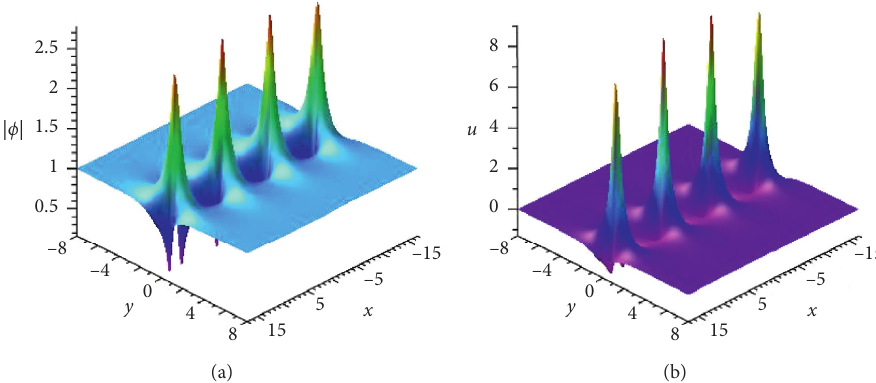
Figure 1: The one-breather solutions | ϕ | and u of the nonlocal Mel ′ nikov equation given by equation (18) with parameters κ � 1/2 , P � 2/3 , Q � 1 , η 0 � 0 , and t � 0.